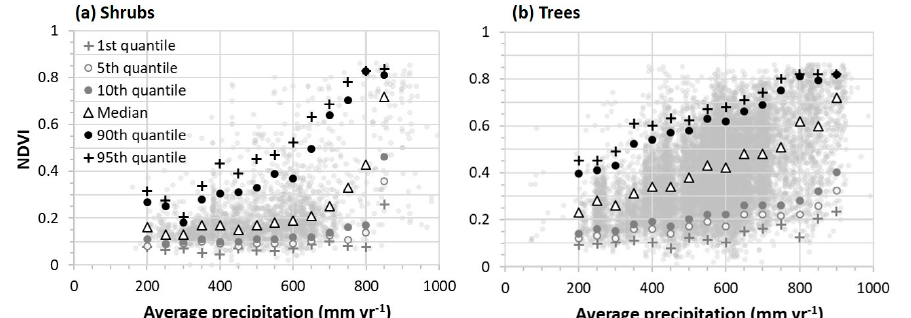
Figure 2. Changes in the Normalized Difference Vegetation Index (NDVI) of shrub and tree cover along the precipitation gradient. Results of all analyzed pixels for shrub cover ( a ) and for tree cover ( b ) are shown in gray. Quantiles for each bin of 50 mm of annual precipitation are shown in greyscale symbols overlying the data.